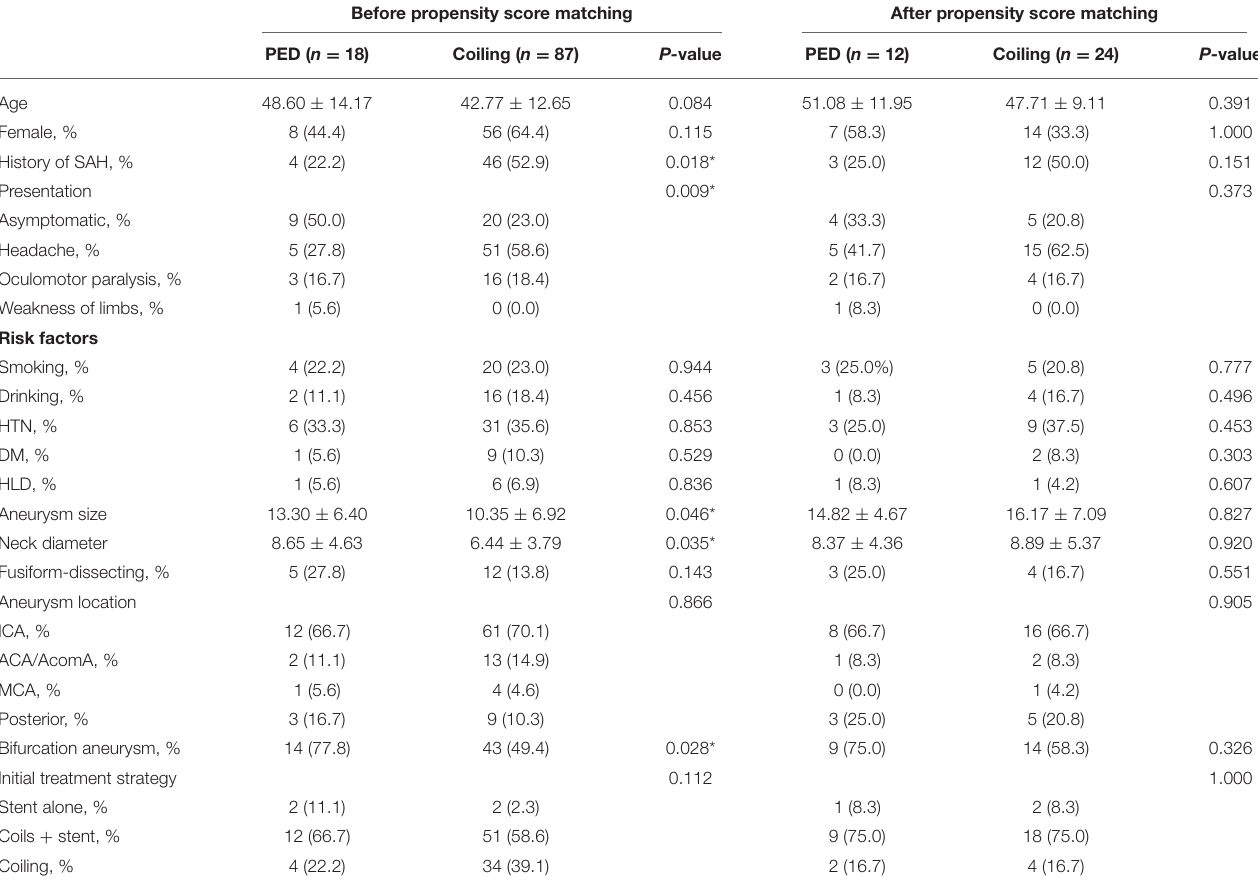
TABLE 1 | Characteristics of patients and aneurysms at initial endovascular treatment before and after propensity score matching. Before propensity score